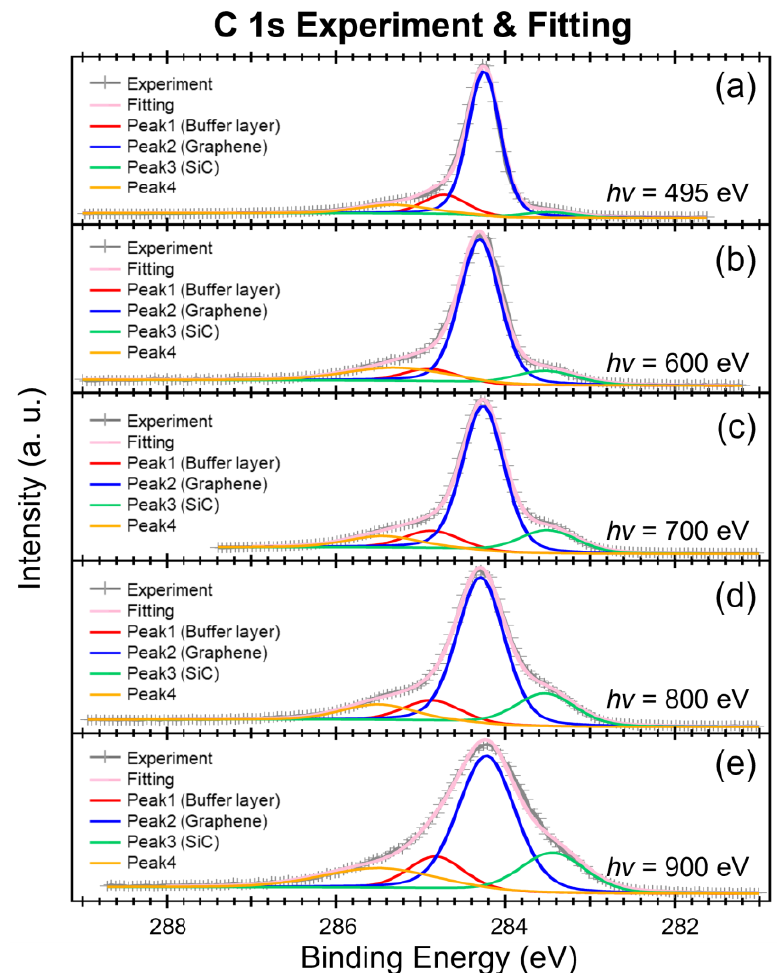
Figure 4. C 1s XPS results of few-layer graphene sample measured by different photon energy: ( a ) 495 eV, ( b ) 600 eV, ( c ) 700 eV, ( d ) 800 eV and ( e ) 900 eV, respectively. As shown in the figure, the peak intensity is depending on the different photon energy used. We use this result to estimate the thickness, which is shown in Table 1. The resolution depends on the photon energy used but is always better than 600 meV. Grey and pink lines are experiment and fitting results, respectively. The red, blue and green peaks represent the signals coming from the buffer layer, graphene and SiC substrate, respectively.